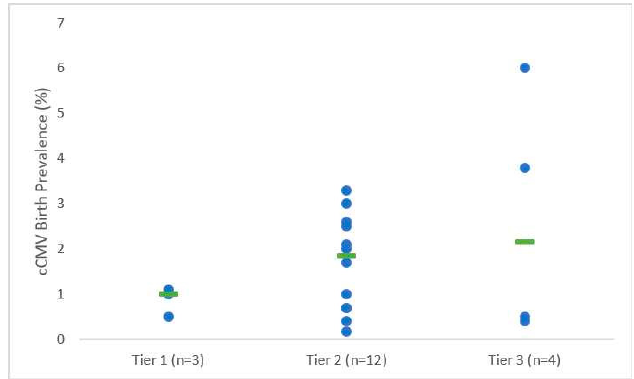
Figure 2. Congenital CMV birth prevalence rates within study tiers. Green bars indicate the median for each tier.